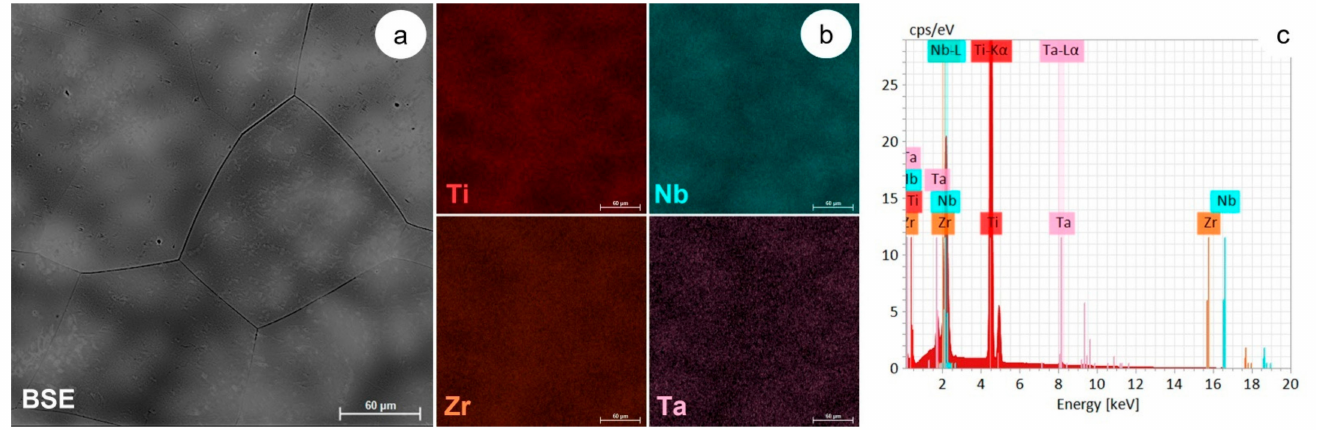
Figure 2. SEM-BSE image of the AR TNZT alloys microstructure ( a ); SEM-EDS colorized maps showing the main alloying elements distribution ( b ); EDS spectra of AR TNZT alloy ( c ). The samples used in this study were subjected to deformation by cold rolling, with various deformation degrees, gradually increasing from 15% to 60%, in 15% steps. All the cold-rolled samples were studied in the RD–ND cross-section (RD—rolling direction; ND—normal direction), but only a few representative images were selected in order to highlight the microstructural